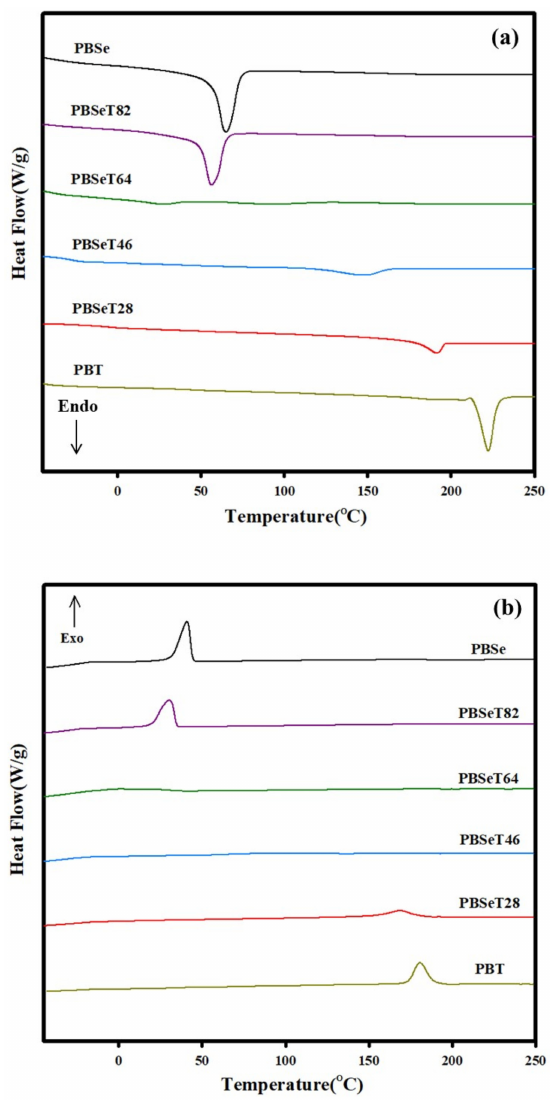
Figure 7. Melting point and crystallization temperatures determined from di ff erential scanning calorimetry (DSC) for the synthesized copolyesters. ( a ) 2nd heating and ( b ) 2nd cooling. Table 5. DSC data of the synthesized polyesters with various sebacic acid:dimethyl terephthalate ratios. PBSe PBSeT82 PBSeT64 PBSeT46 PBSeT28